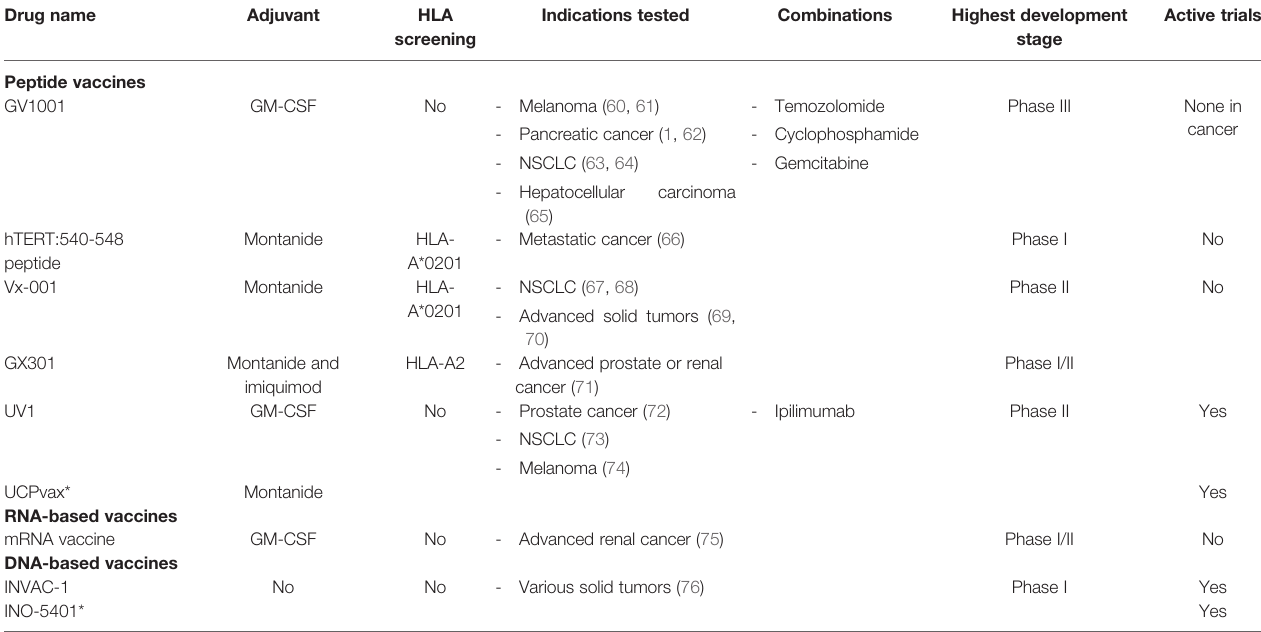
TABLE 1 | hTERT TCV candidates evaluated in clinical trials covering various indications over the past two decades (autologous cell-based therapies are not included). Drug